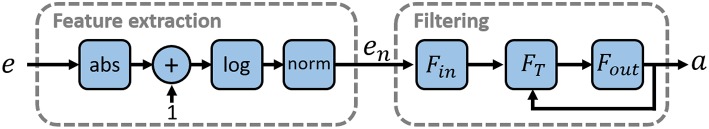
EMGs Pre-processing phase, extracting informative, and independent features from EMG acquisitions. We first perform the feature extraction, and after we filter the data using an adaptive filter.